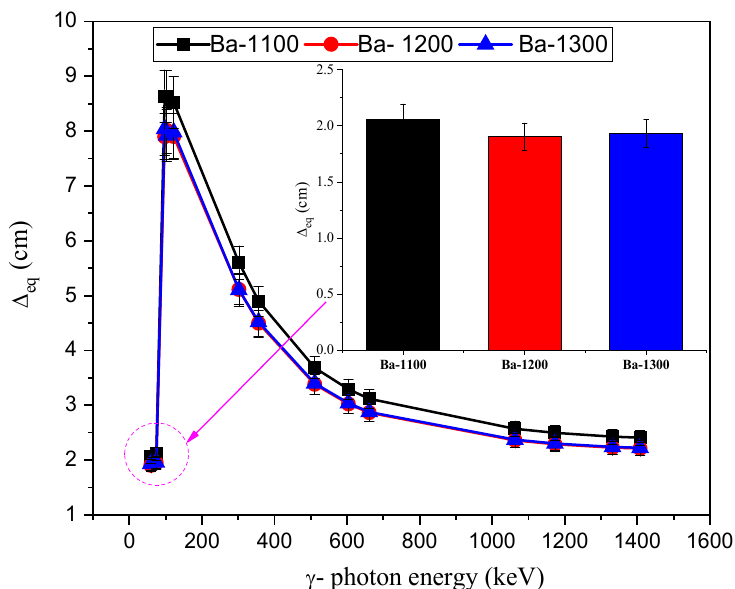
Figure 8. Dependence equivalent thickness ( ∆ eq , cm) on the emitted γ -photon energy (E γ , keV) for the prepared samples.